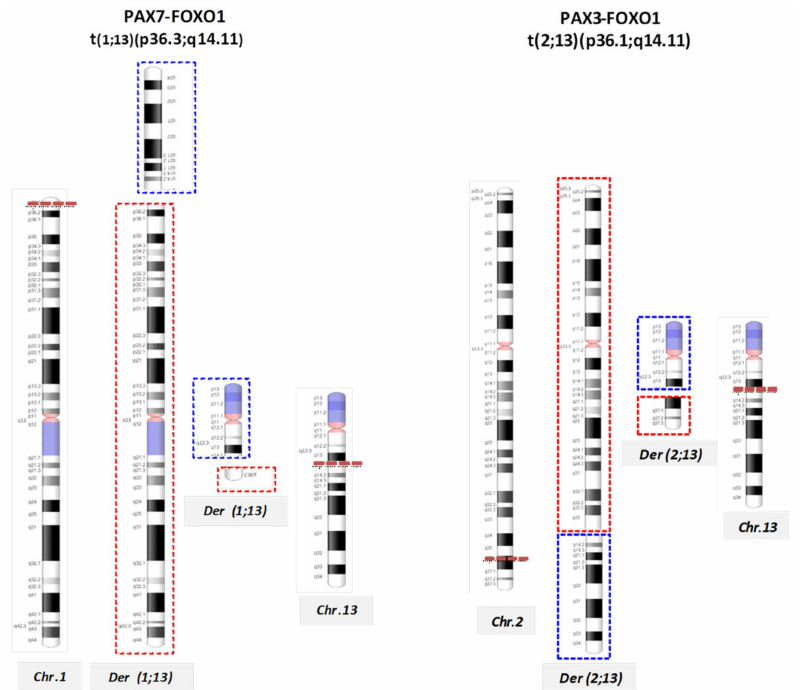
Figure 2. Chromosomal rearrangements in alveolar RMS ARMS. A diagram of t(1;13)(p36.3;q14.11) and t(2;13)(q35;q14) illustrates reciprocal translocations that generate fusion genes PAX7-FOXO1 and PAX3-FOXO1, respectively. The red and blue dotted lines delineate the derivative chromosomes: the red boxes represent regions of chromosome 1 (on the left) and chromosome 2 (on the right) involved in the rearrangement, while the blue ones illustrate the translocated region of chromosome 13 ( both on the left and